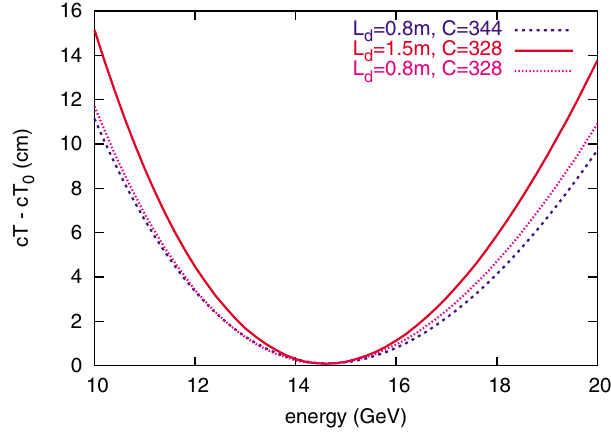
FIG. 19. (Color) Variation in revolution period with energy for three lattices. Parameters are given in Table III.